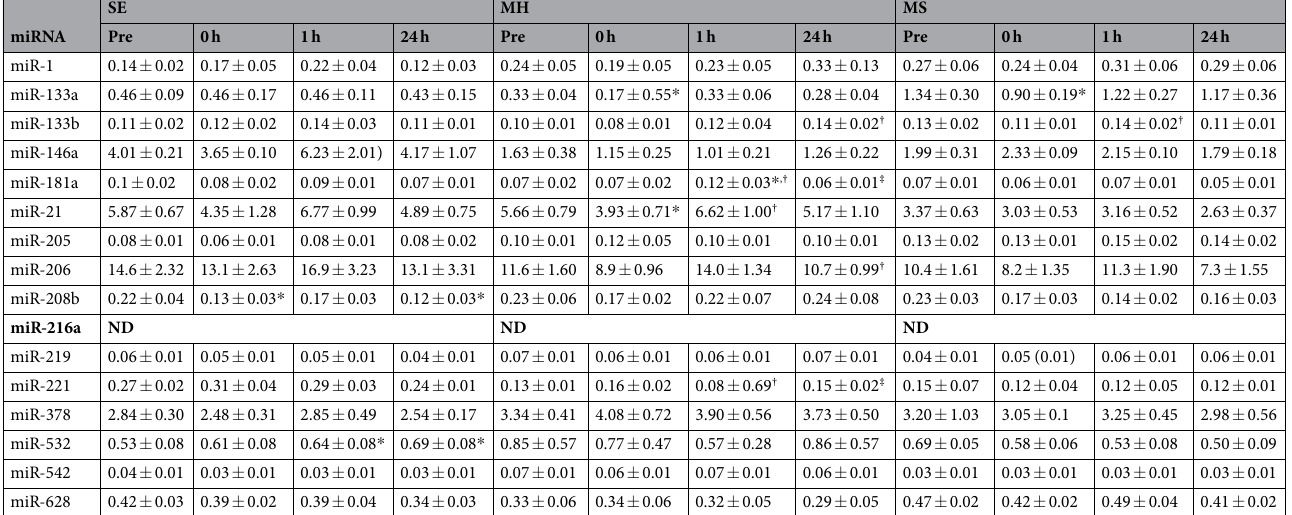
Table 3. The relative concentrations of 16 plasma miRNAs chosen from TLDA determined by RT-qPCR assay for the SE, MH and MS protocols. The relative concentrations of the circulating miRNAs were normalized to the Let-7d/g/i and presented as the mean ± SEM. miRNAs were obtained from plasma samples at baseline (Pre), immediately after exercise (0 h), after 1 h of recovery (1 h), after 24 h of recovery (24 h). * p < 0.05 compared to Pre; † p < 0.05 com p ared to 0 h; ‡ p < 0.05 compared to 1 h. ND, non-detected values. Values obtained from 15 subjects separately in each of the three